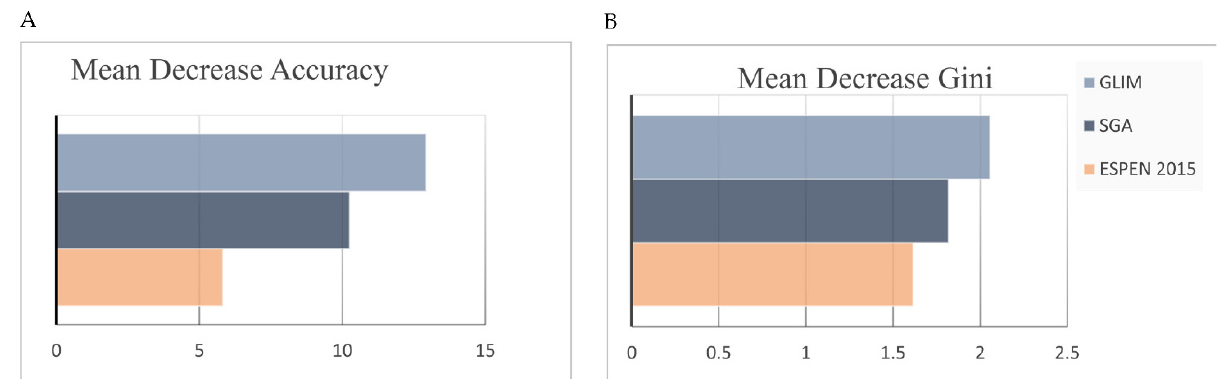
Figure 3. Mean decrease accuracy and mean decrease Gini coefficients of the three malnutrition diagnosis criteria predicted by the random forest algorithm. ( A ) Mean decrease accuracy. ( B ) Mean decrease Gini. GLIM, Global Leadership Initiative on Malnutrition; SGA, subjective global assess- ment; ESPEN 2015, the 2015 consensus statement by the European Society for Clinical Nutrition and Metabolism.